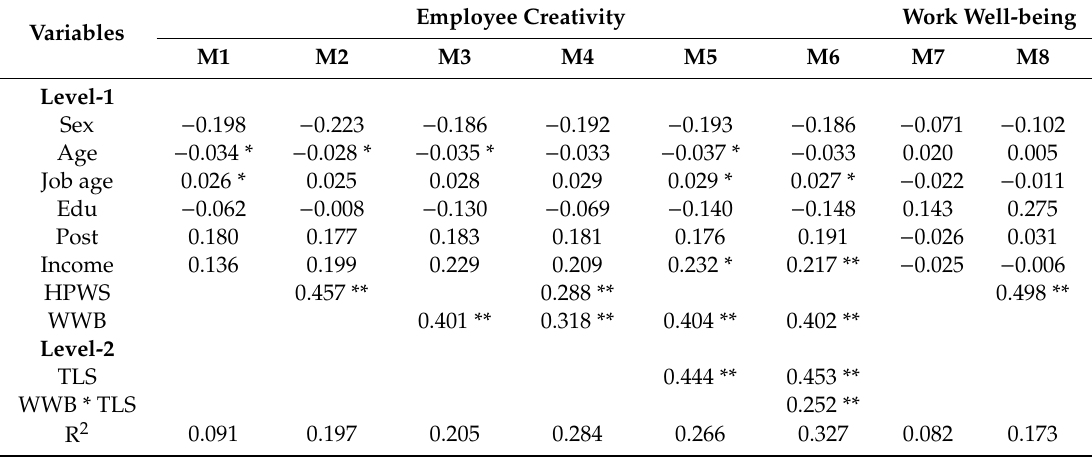
Table 4. HLM results: mediating and moderation e ff ect of work well-being. Employee Creativity Variables